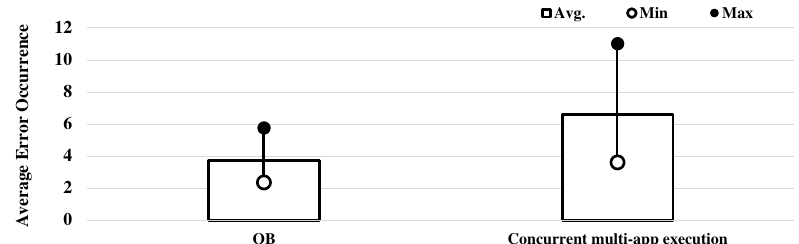
Figure 3. Memory allocation failure occurrence in the Non-Shared-Memory